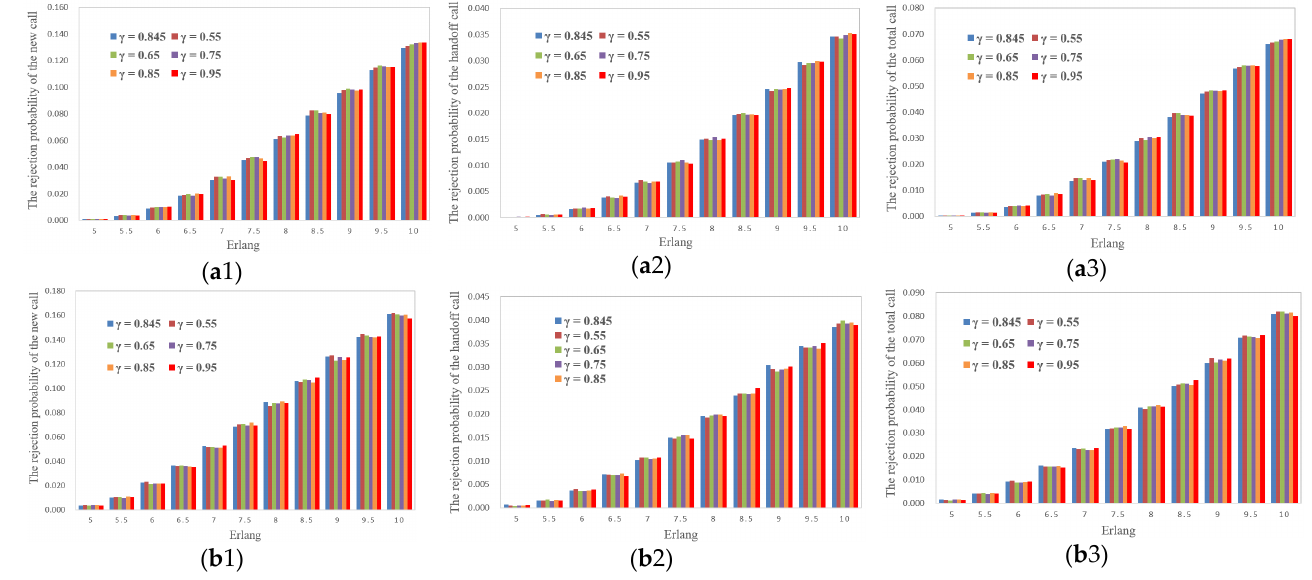
Figure 7. Performance comparison of TSCA with different values of gamma. ( a 1) The rejection probability of the new call under uniform distribution; ( a 2) the rejection probability of the handoff call under uniform distribution; ( a 3) the rejection probability of the total call under uniform distribution; ( b 1) the rejection probability of the new call under nonuniform distribution; ( b 2) the rejection probability of the handoff call under nonuniform distribution; ( b 3) the rejection probability of the total call under nonuniform distribution.